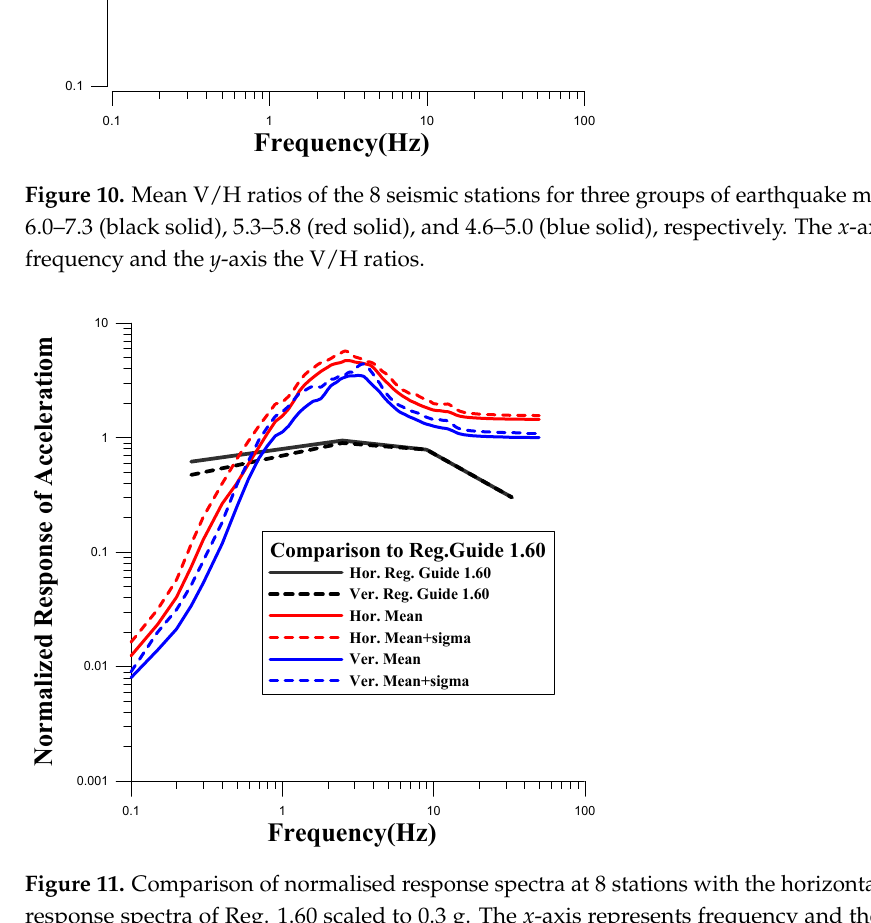
Figure 11. Comparison of normalised response spectra at 8 stations with the horizontal and vertical response spectra of Reg. 1.60 scaled to 0.3 g. The x -axis represents frequency and the y -axis is the amplification factor, equivalent to the response spectrum acceleration.